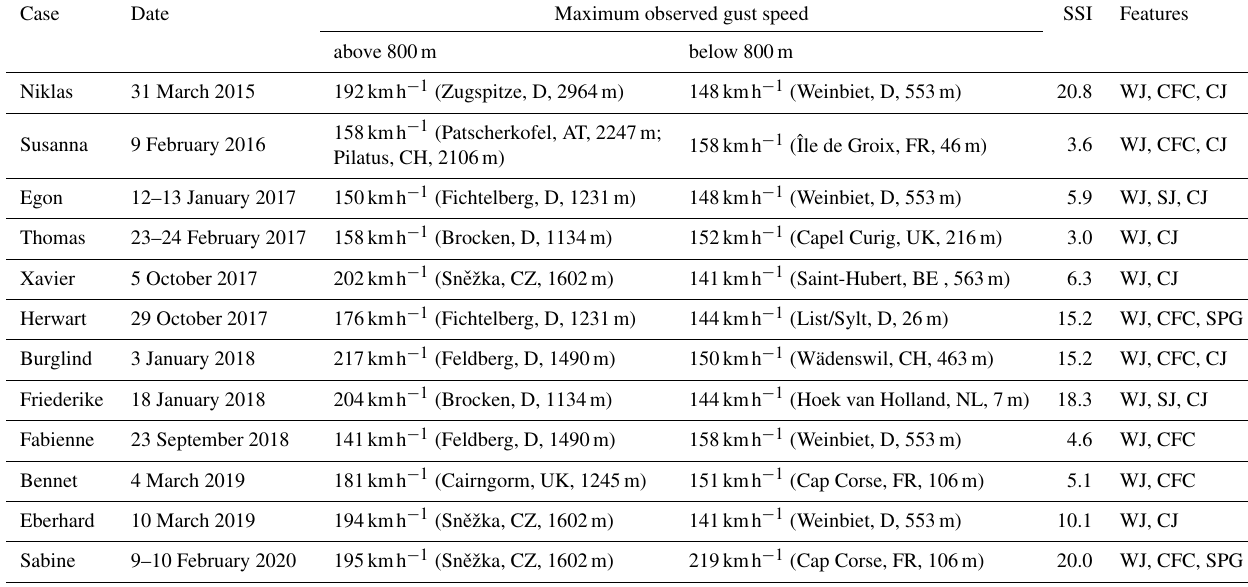
Table 2. Selected winter storm cases from 2015 to 2020 over central Europe, showing the name (as given by the Free University of Berlin), date, maximum observed gust speed (location), SSI over Germany and associated high-wind features including exceptional large pressure gradients (SPG). The cyclone tracks are displayed in Fig.